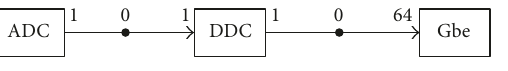
Figure 31: An SDF diagram of the FM